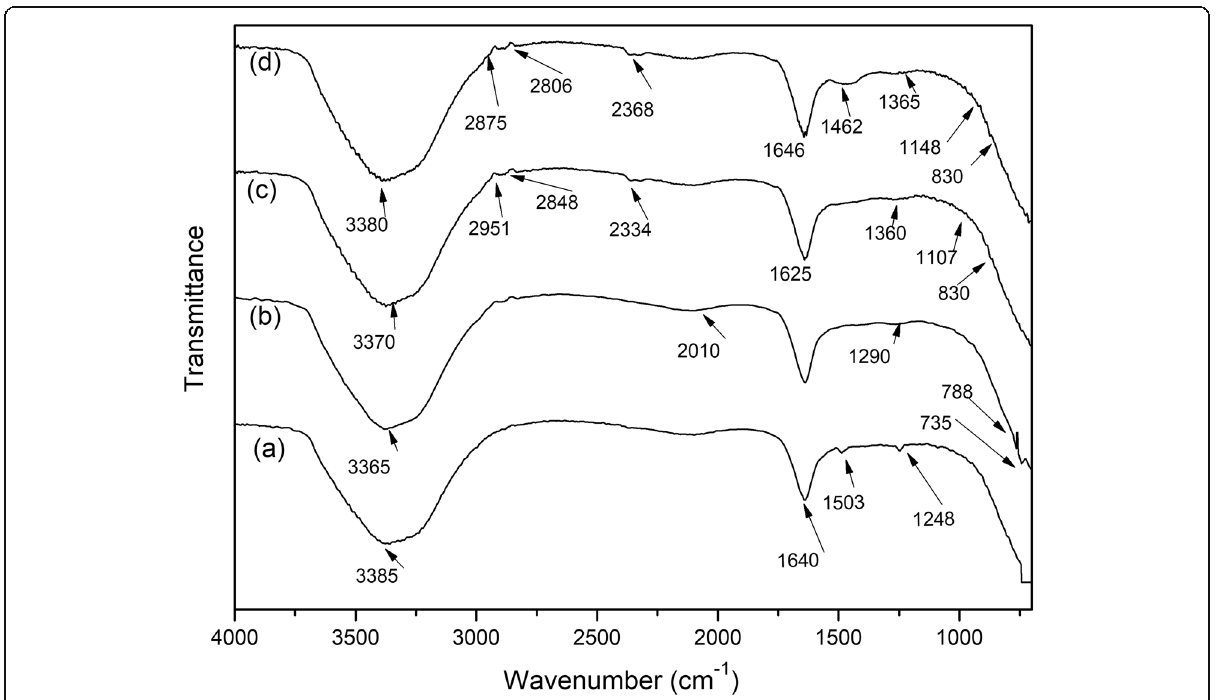
Fig. 2 Fourier-transform infrared-attenuated total reflection spectra of a silk sericin, b AgNO 3 solution, c 1:6 SS-AgNPs, and d 1:8 SS-